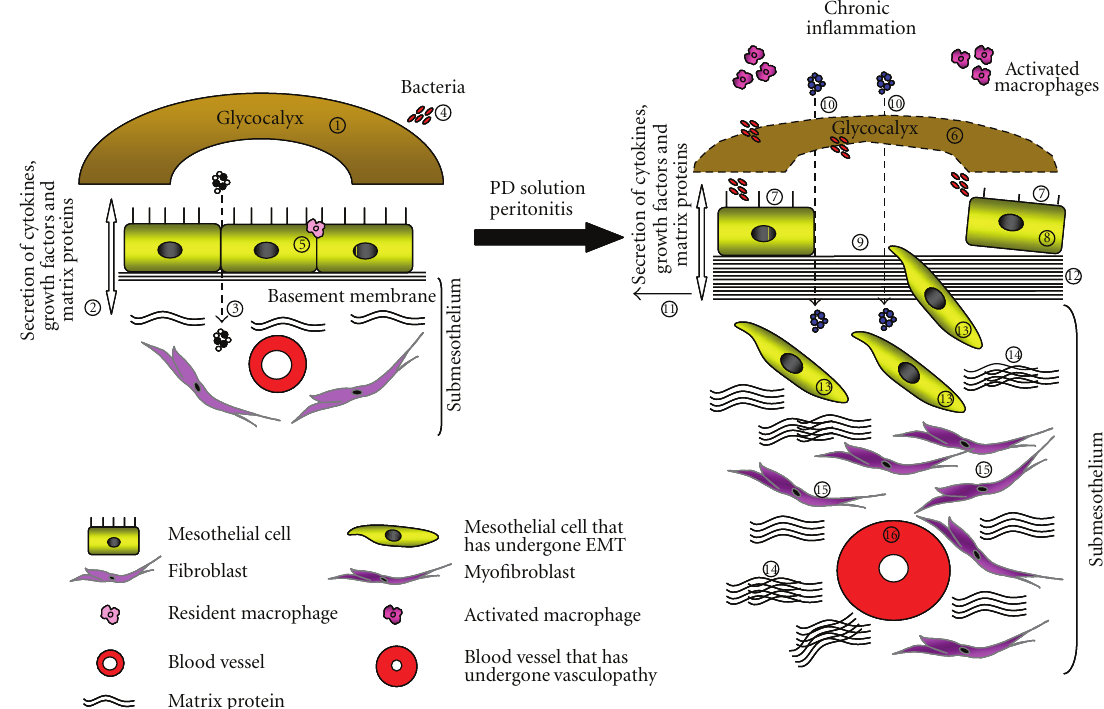
Figure 1: Mesothelial cells line the peritoneal membrane and play a crucial role in peritoneal homeostasis. Their apical surface is endowed with a glycocalyx that provides a protective barrier against abrasion, and a slippery, nonadhesive surface for intracoelomic movement (1). Through their ability to synthesize various cytokines, growth factors, and matrix protein components, mesothelial cells actively participate in tissue repair and induction and resolution of peritoneal inflammation (2). Synthesis of matrix proteins by mesothelial cells may be incorporated into the underlying basement membrane on which mesothelial cells adhere to. Mesothelial cells facilitate in the transport of fluids and solutes across the peritoneal membrane (3), are the first line of defense against bacterial peritonitis (4), and can maintain a chemotactic gradient to assist in leukocyte infiltration (5) during peritoneal inflammation. The submesothelium contains sparse fibroblasts, collagen fibrils and capillaries. Changes to the structural integrity of the peritoneal membrane are invariably observed in PD patients. Constant exposure of the peritoneum to PD fluids, together with peritonitis, results in a reduction of the glycocalyx volume and a concomitant loss of anionic charge in the glycocalyx (6). Alterations in the anionic charge of the peritoneum can result in the reduction in the length and density of microvilli on the surface of mesothelial cells (7). Chronic exposure to PD fluid and peritonitis can induce detachment of mesothelial cells from their underlying basement membrane (8) resulting in partial (9) or complete denudation of the mesothelium. A loss of cell-cell interaction between mesothelial cells permits PD fluid to enter into the submesothelium (10). Increased synthesis of proinflammatory cytokines and matrix proteins is observed following the activation of infiltrating and resident peritoneal cells (11), leading to morphological changes such as reduplication of the basement membrane (12), induction of EMT in mesothelial cells, a breakdown of the basement membrane and their migration into the submesothelium (13). Transdi ff erentiated mesothelial cells have a greater fibrogenic potential and thus contribute to the deposition of matrix proteins and fibrin in the submesothelium (14), which if not controlled will lead to thickening of the submesothelium and ultimately peritoneal fibrosis and sclerosis. A loss of the protective mesothelium allows PD fluid and toxins released by bacteria to induce the activation of peritoneal fibroblasts (15), hyalinization of blood vessels, and vasculopathy (16). Such detrimental changes to the peritoneal membrane will significantly suppress the dialytic potential of the peritoneal membrane, which will invariably lead to the cessation of